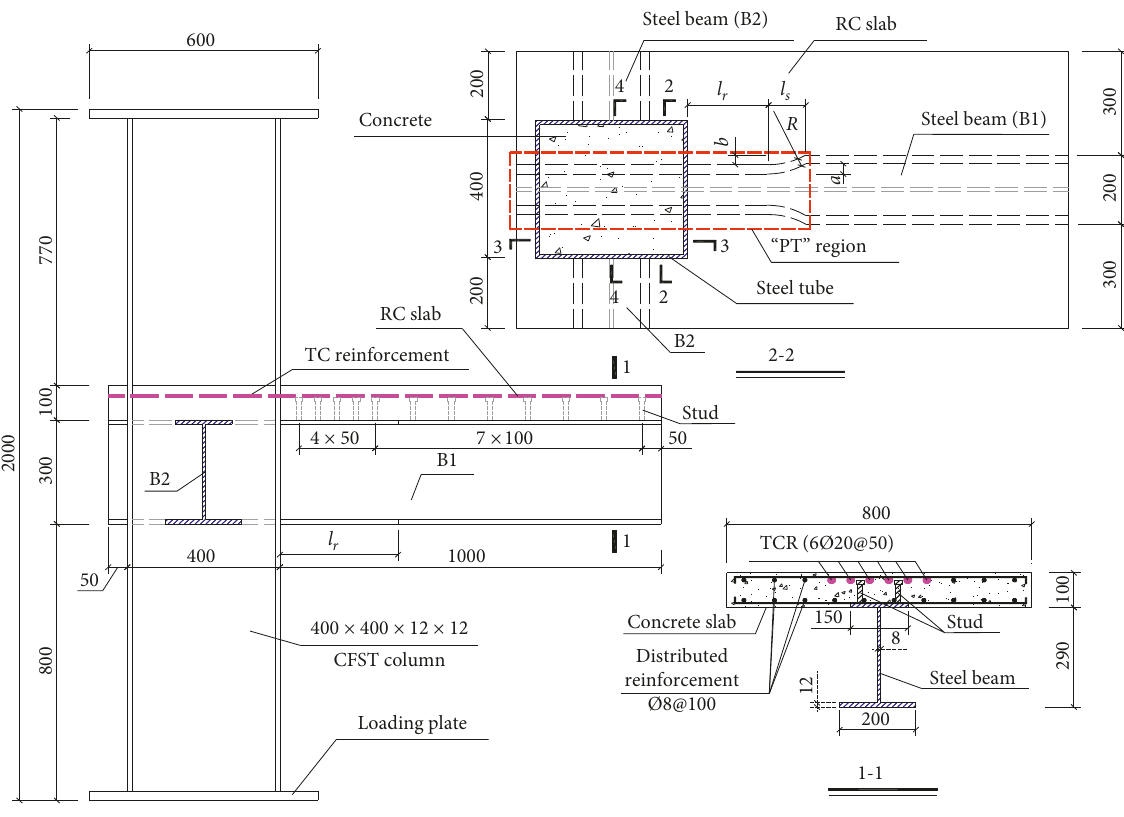
Figure 2: Details of specimens (units: mm).